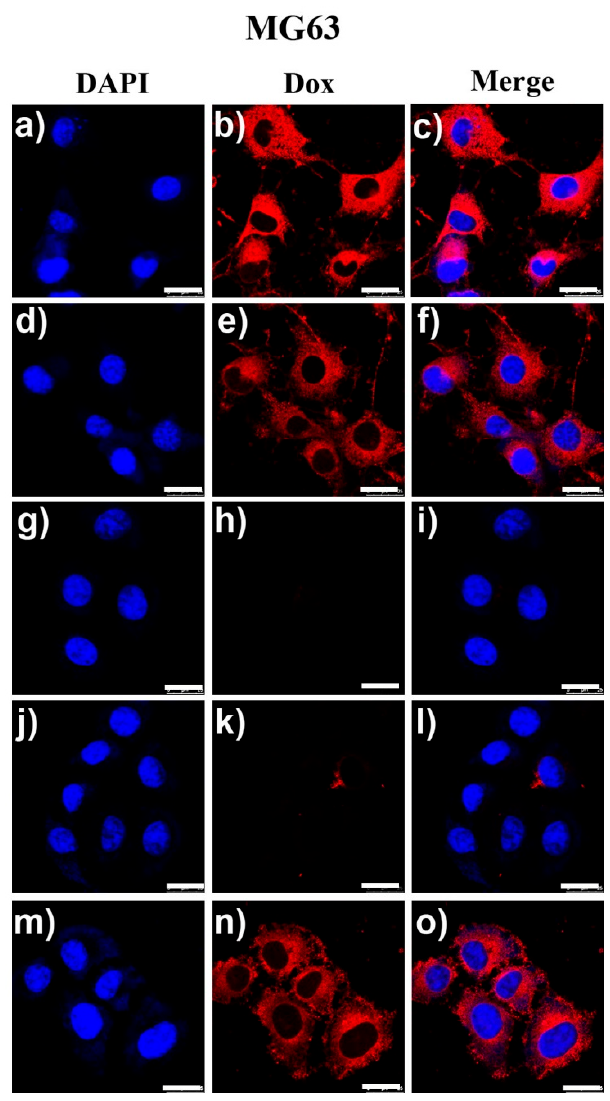
Figure 6. MG63 cells cultured in different conditions for 24 h: ( a – f ) with free Dox (1 μ g/mL), ( g – i ) blank control group, and ( j – o ) with DCAT NSs (concentration of Dox = 1 μ g/mL). Cells in ( a – c ) and ( j – i ) were cultured at pH = 7.4; ( d – f ) and ( m – o ) were at pH = 5.0.